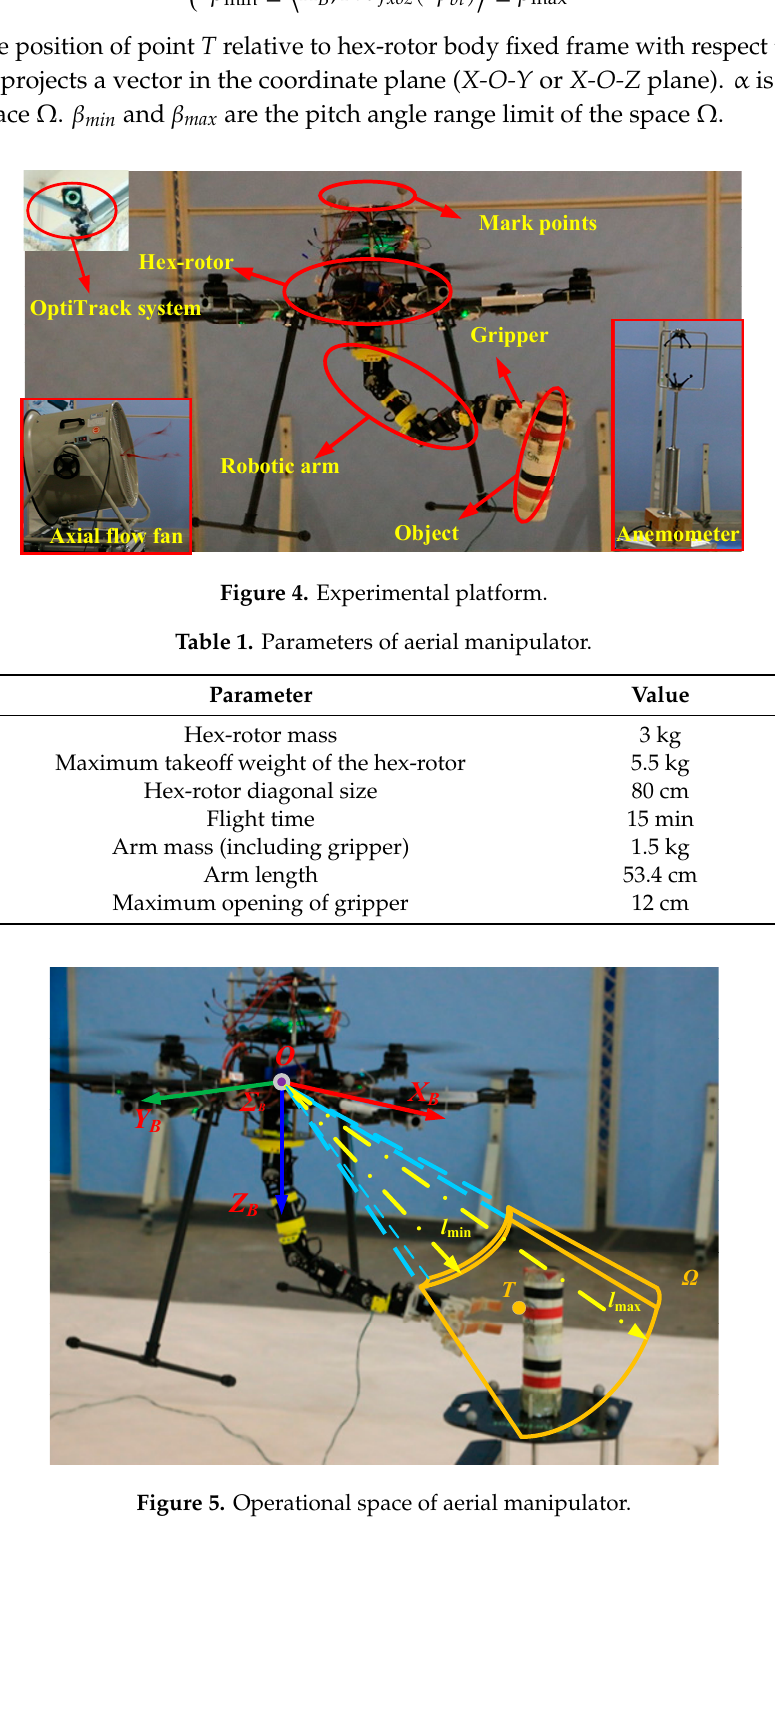
Figure 5. Operational space of aerial manipulator.